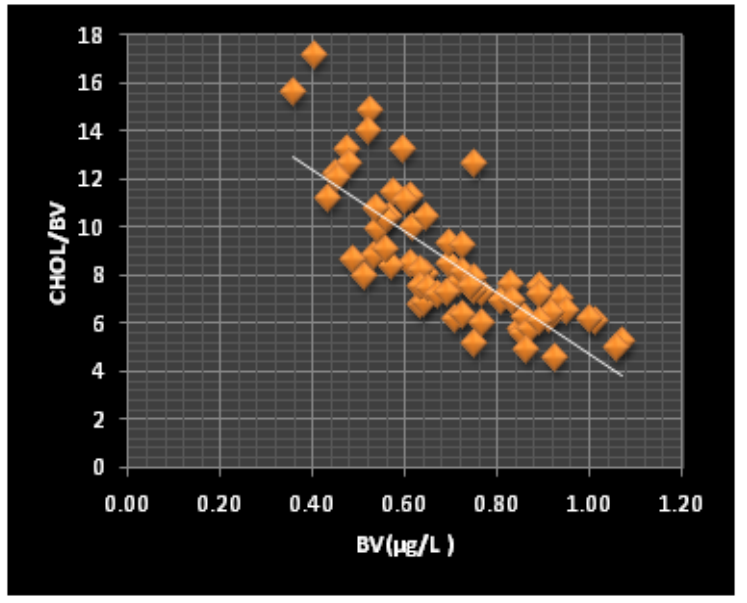
Figure 3. The correlation between the BV levels and the Chol/BV ratio (r = − 0.78, p < 0.0001) in the ThPP workers.